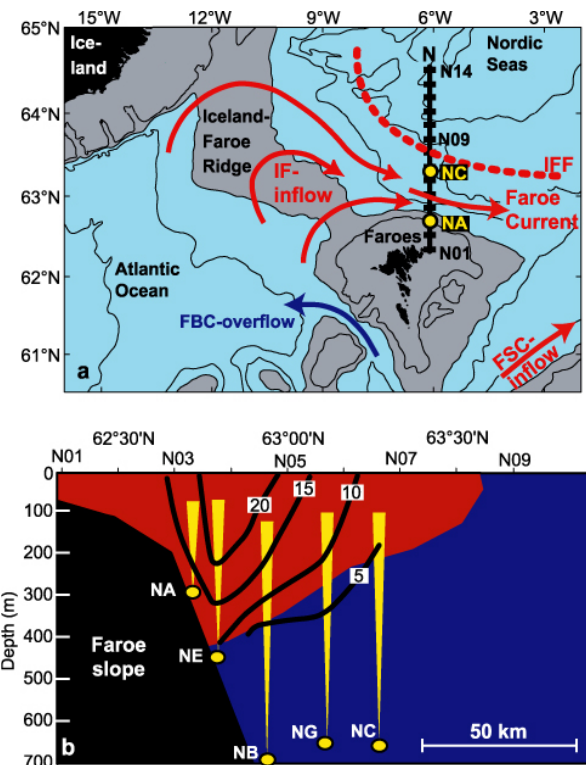
Fig. 1. Geographical setting and characteristics of the IF-inflow and observational system. (a) Bottom topography (gray areas shal- lower than 500m). Red arrows show the two main Atlantic inflow branches, the one across the IFR, which is bounded by the Iceland- Faroe Front (IFF), and the one through the Faroe-Shetland Channel (FSC-inflow). The black line with rectangles labeled N01 to N14 is a standard section with fixed CTD stations. Yellow circles indi- cate the southernmost (NA) and northernmost (NC) ADCP mooring locations. Blue arrow indicates overflow through the Faroe Bank Channel (FBC-overflow). (b) The southern part of the standard sec- tion with the red area indicating water of salinity > 35.00 on aver- age 1997–2001 (based on Hansen et al., 2003). Thick black lines show average eastward velocities from summer 2000 to summer 2001 with values in cms − 1 (based on Hansen et al., 2003). Yel- low circles indicate moored ADCPs with typical ranges indicated by yellow